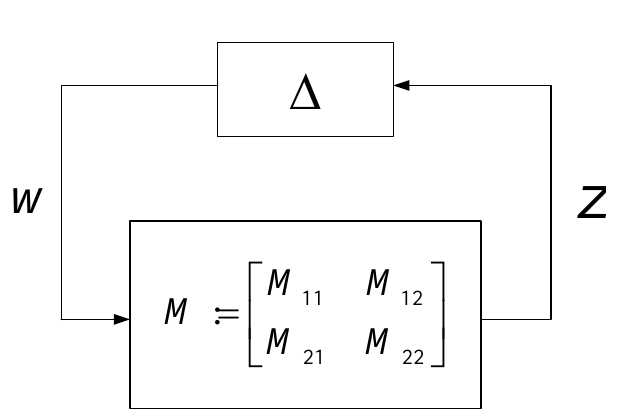
Figure 17 . Structure of robustness analysis using SSV [35]. Figure 17. Structure of robustness analysis using SSV